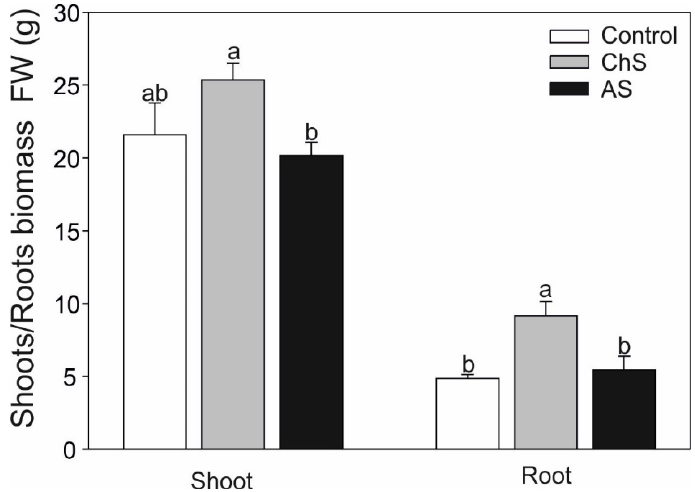
Figure 1. Effect of long-term chronic cadmium stress (ChS, 0.1 µM Cd, 85 days) or short-term acute Figure 1. E ff ect of long-term chronic cadmium stress (ChS, 0.1 µ M Cd, 85 days) or short-term acute cadmium stress (AS, 10 µM Cd, 4 days) on the fresh weight of Carlina acaulis organs. Data are means cadmium stress (AS, 10 µ M Cd, 4 days) on the fresh weight of Carlina acaulis organs. Data are means ± ± SE ( n = 8–10); values followed by the same letter are not significantly different ( p < 0.05, Tukey’s SE ( n = 8–10); values followed by the same letter are not significantly di ff erent ( p < 0.05, Tukey’s test).